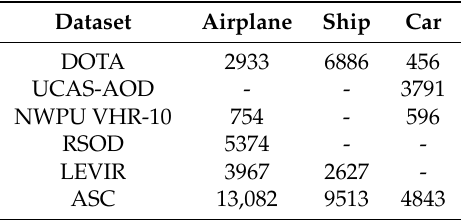
Table 1. A Summary of Objects in ACS